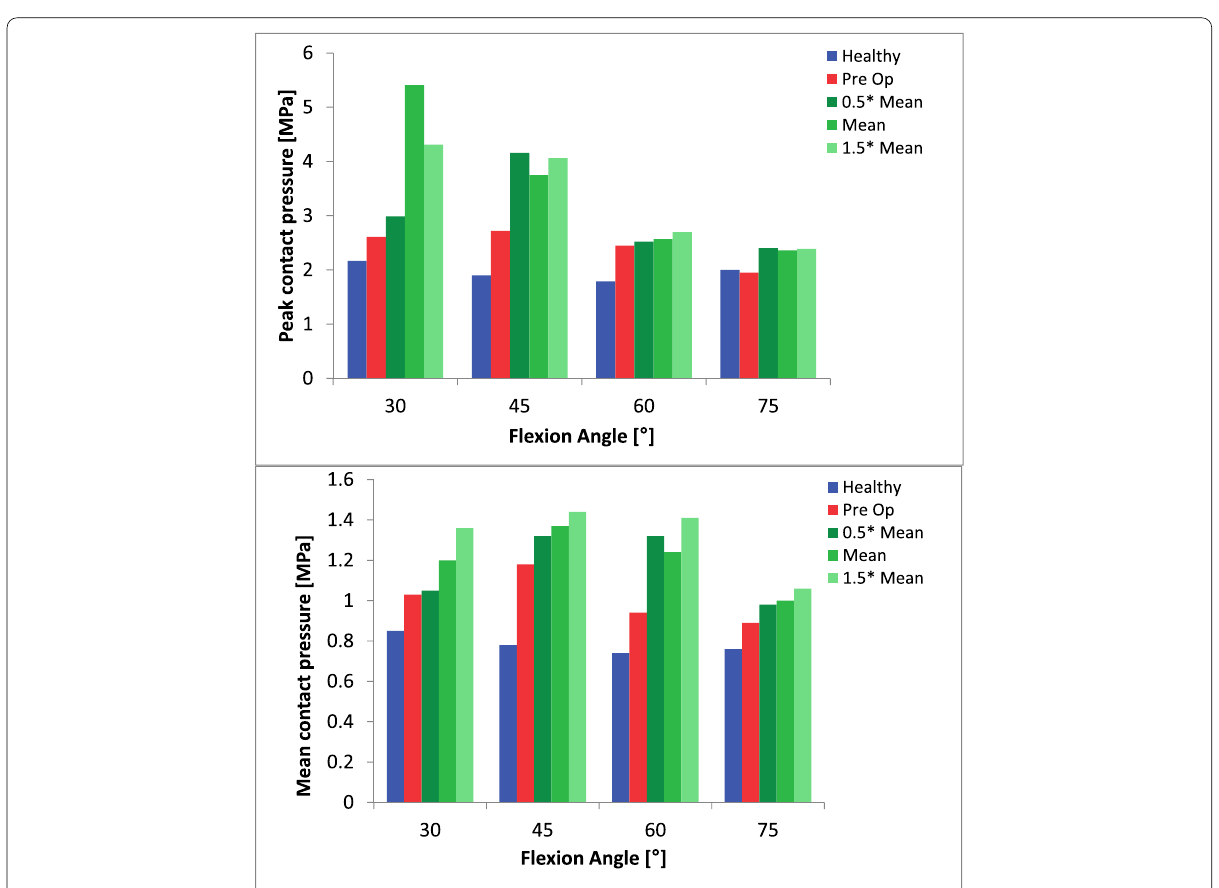
Fig. 2 Peak and mean contact pressure subdivided into knee flexion angle for the „healthy knee“model (blue) and for the „trochleodysplastic knee“model both pre-(red) and postoperatively (green) are depicted. The latter is depicted with varied surgical parameters ranging from 0.5x mean to 1.5x